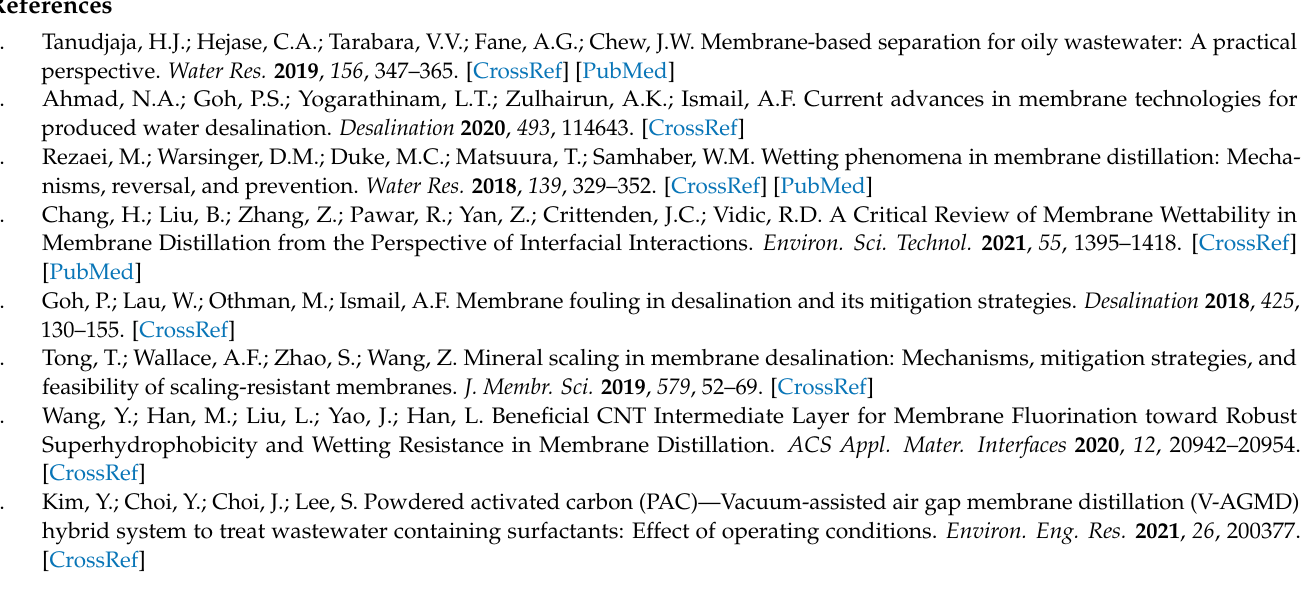
Figure A4. Conductance ( a ) and capacitance ( b ) of the pristine membranes in electrolyte (1 M NaCl solution), respectively. Capacitance of PVDF ( c , e ) and PTFE ( d , f ) membrane versus MD duration for feeds with different PDS concentrations ( c , d ) and temperatures ( e , f ) according to Figures 4 and 5, respectively.